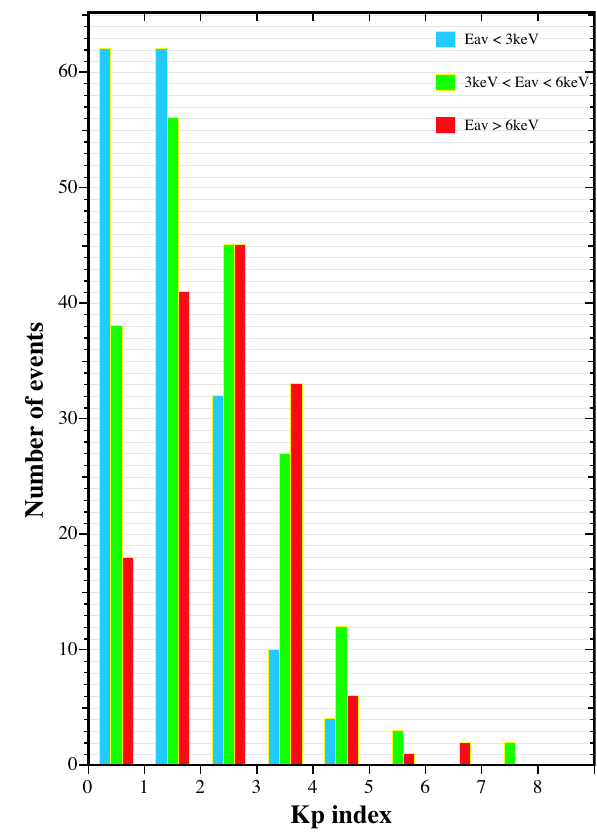
but cannot be exactly determined because it depends on the Fig. 9. Distribution of full-width half-maximum (FWHM) values energy flux maximum of each event. Fig. 9. Distribution of full-width half-maximum (FWHM) values of the inverted-V’s for events with peak energies of less than 3keV (blue), between 3 and 6keV (green), and more than 6keV (red).